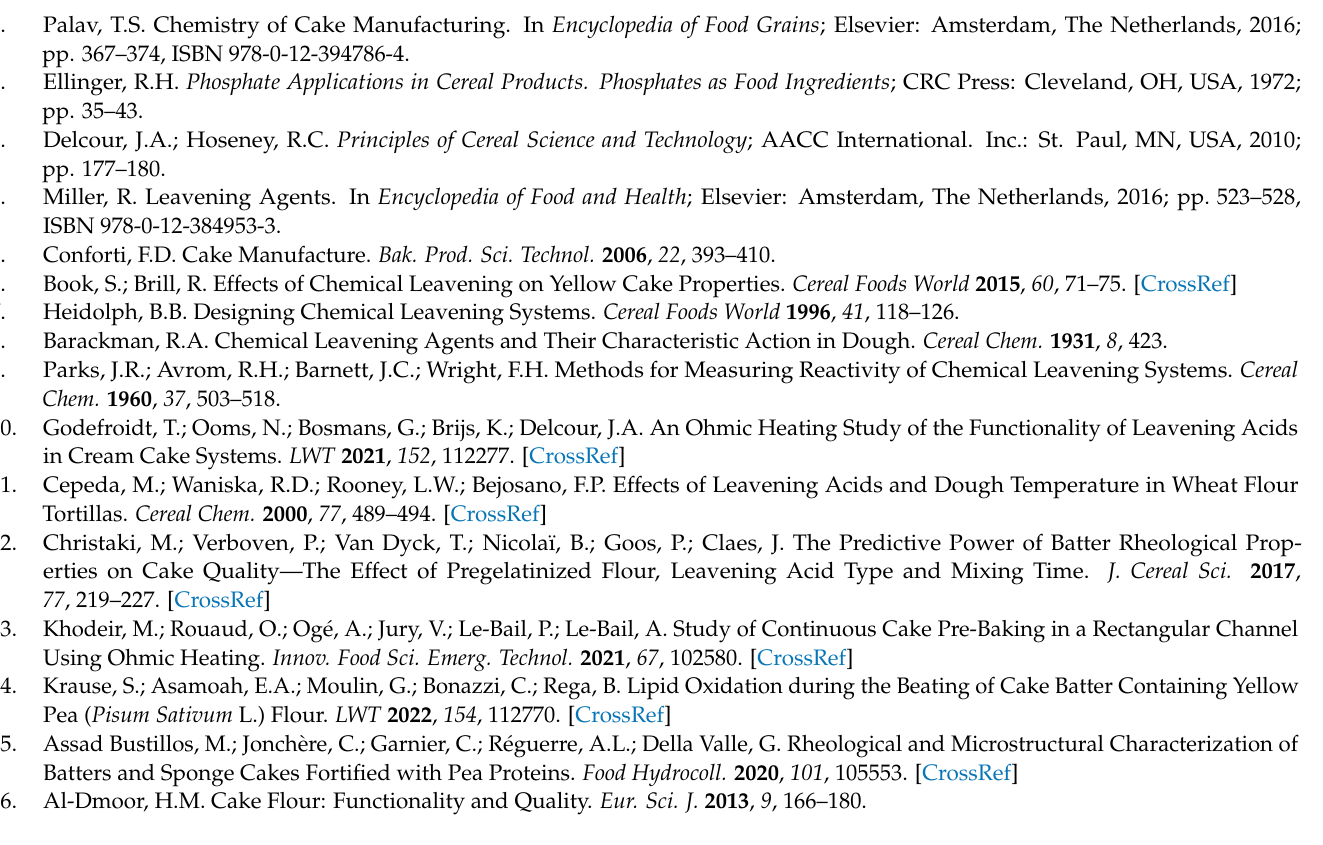
Table S2: Parameters selected as responses; Table S3: Classification of significance levels in Table 3 with respect to p -values with 95% confidence interval; Equation S1–S8: Regression equations of